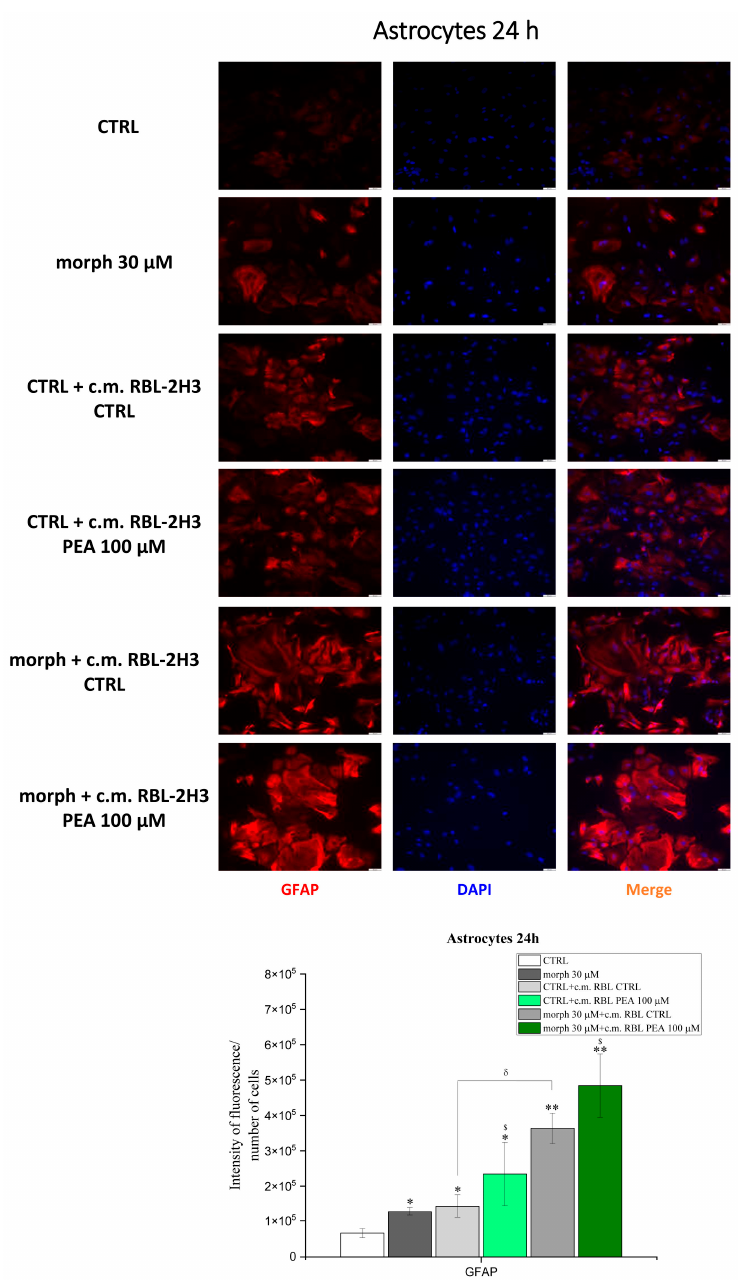
Figure 6. Effect of control and PEA pre-treated RBL-2H3 medium on astrocyte GFAP expression. Immunofluorescence of GFAP on astrocytes treated with 30 µ M morphine (48 h) and c.m. from RBL-2H3 (24 h) stimulated with DNP-BSA (625 ng/mL, 24 h) and pre-treated or not (control) with 100 μ M PEA. Cell nuclei were labeled with DAPI. Values are expressed as the mean ± S.E.M. of three experiments. Scale bar = 50 μ m. * p < 0.05; ** p < 0.01 vs. control astrocytes. $ p < 0.05 vs. astrocytes + c.m. RBL-2H3 CTRL. δ p < 0.05; morphine astrocytes + c.m. RBL-2H3 CTRL vs. control astrocytes + c.m. RBL-2H3 CTRL.